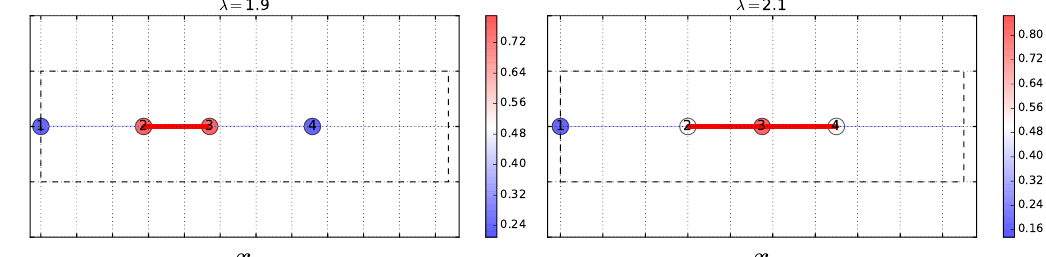
Figure 11: Solution in the nonintegrable case, λ ̸ = 2. λ < 2 (left): the pair of electrons ensures a strong covalent bond between sites 2 and 3 (dimer), other bonds are weaker. λ > 2 (right): the pair of electron occupies a trimer, other bonds are weaker. The unit-cell (dashed rectangle) with N = 4 atoms is periodically repeated. The density of electrons is indicated by the color scale, it is strong in red and weaker in blue. The integrable case appears as a special point where dimer and trimer, as well as continuous configurations between them, are degenerate. Here, p = 0.02, ξ = 2, ξ = 4